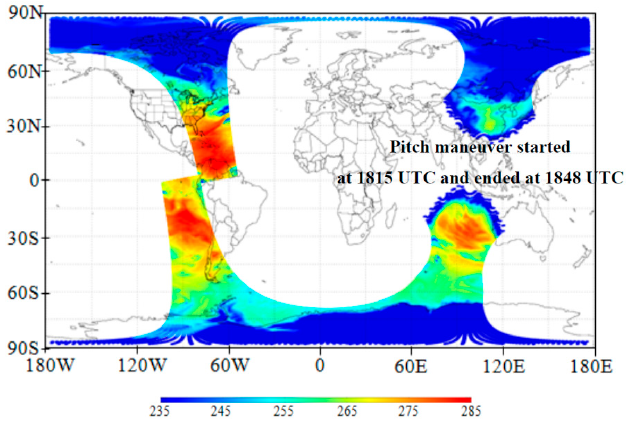
Figure 3. Suomi NPP ATMS orbital brightness temperatures at channel 18 on 20 February 2012.